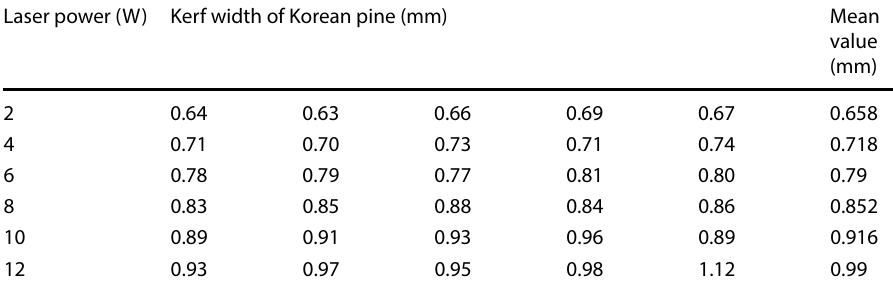
Table 5 Kerf width data of Korean pine (Pinus Koraiensis) under M